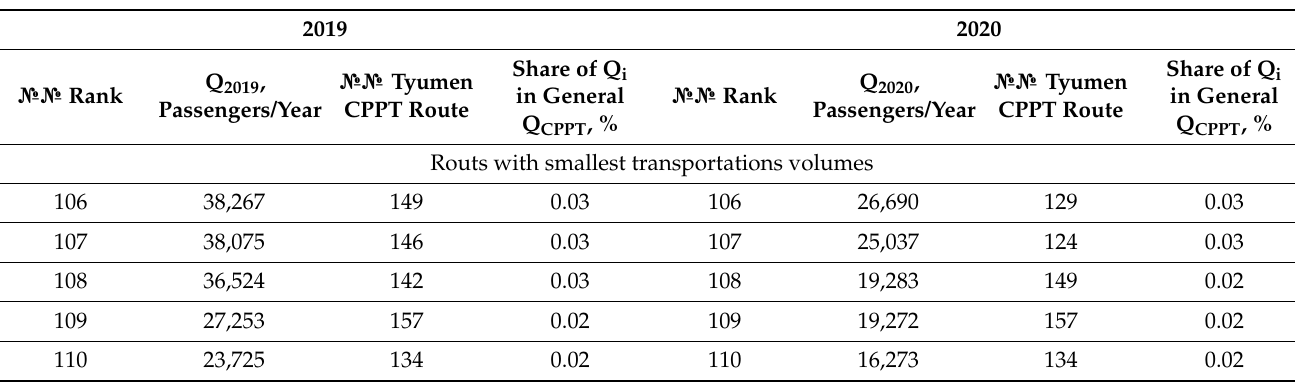
Table 8. Characteristics of cumulative curve (Lorenz curve) of distribution of annual transportation volume Q year at Tyu- men CPPT routes.